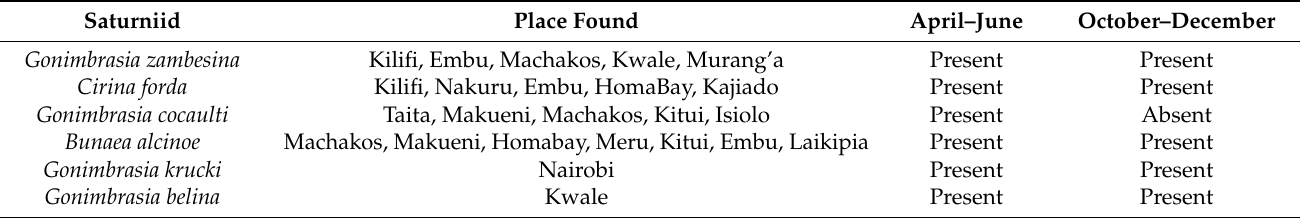
Table 4. Seasonality and distribution of edible saturniids in